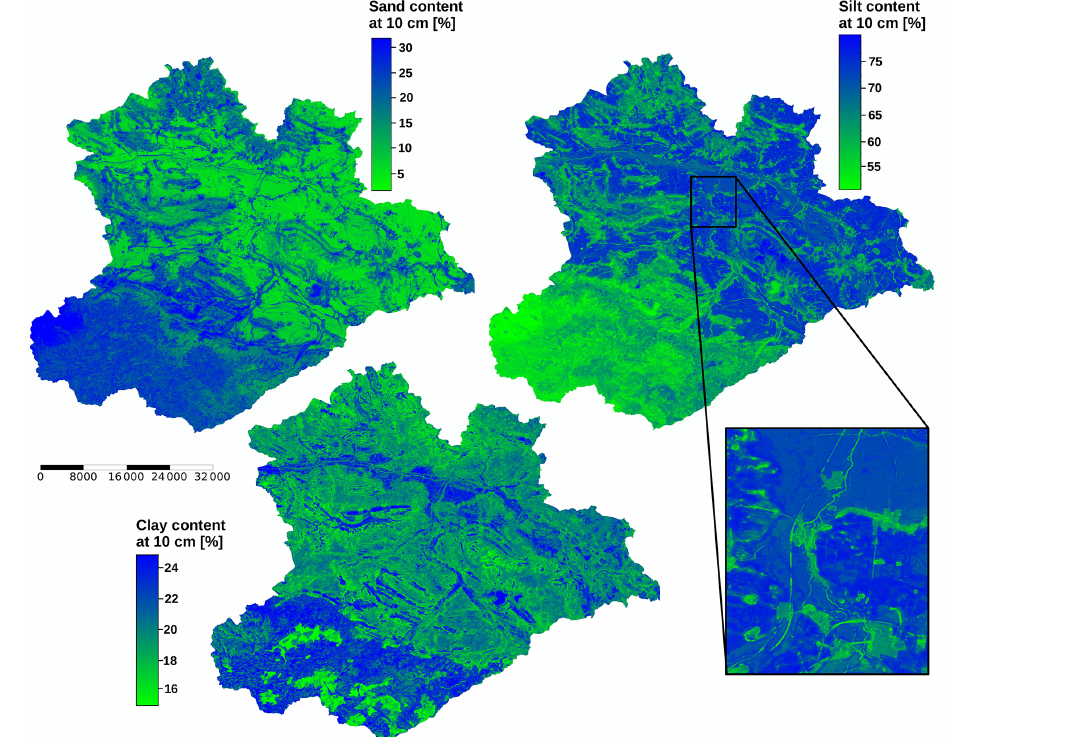
Figure 12. Median of all predictions for sand, silt, and clay content at 10cm depth. The maps show the output of the models built without using the geologic maps, longitude, and latitude as predictors. The scale bar shows distance in